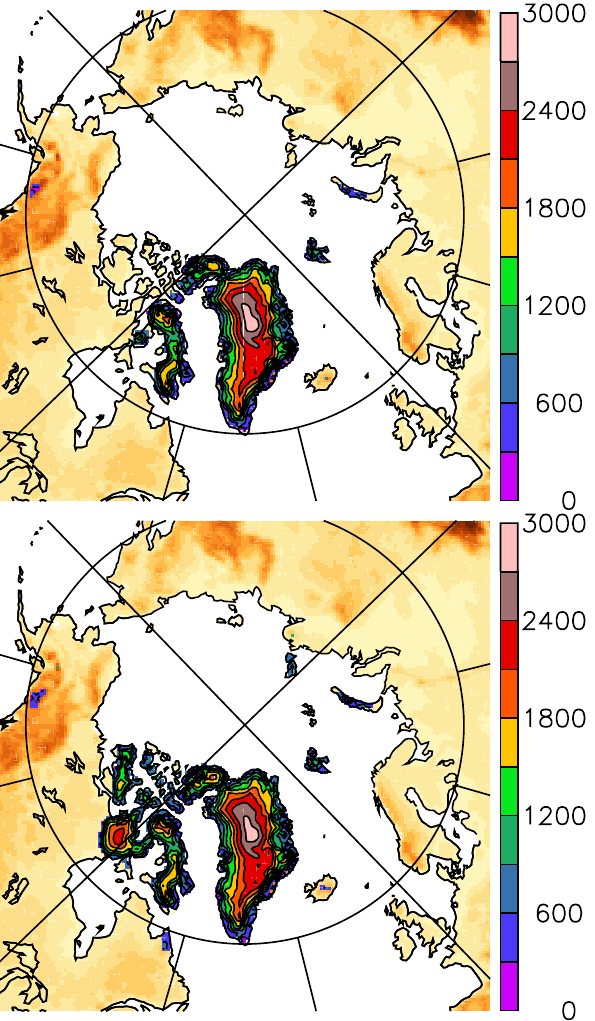
Fig. 2. Modelled ice thickness (in m) for present day (upper) and 115ka (lower). Preindustrial ice area and thickness are well repro- duced. Besides the Greenland ice sheet, smaller ice caps are visi- ble in the Canadian Arctic, Spitsbergen, Iceland, Novaya Zemlya, and south eastern Alaska. Most important differences with 115ka forcing is additinal ice growth in northern continental Canada, Labrador, western Siberia and the Eurasian Arctic islands.